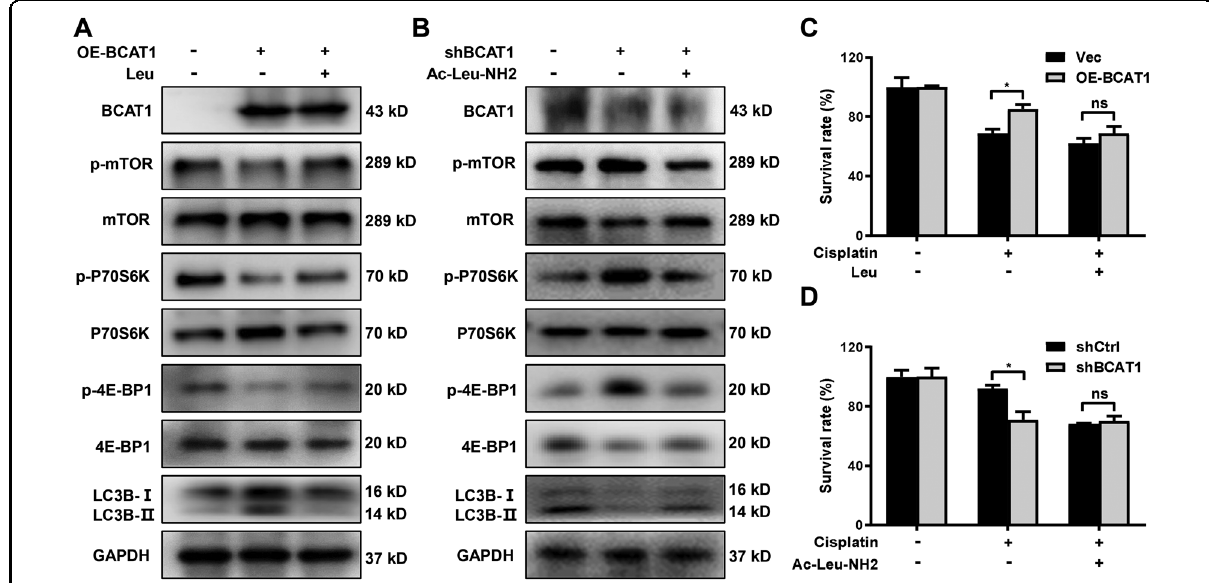
Fig. 5 BCAT1 enhances autophagy and decreases cisplatin sensitivity via leucine (Leu) reduction. A Western blot analysis of the protein levels of BCAT1, mTOR, p70S6K, 4E-BP1 and their phosphorylated counterparts and LC3-I/II in Hela cells with BCAT1 overexpression or in combination with Leu (2 mM) treatment for 24 h. B Western blot analysis of the protein levels of BCAT1, mTOR, p70S6K, 4E-BP1 and their phosphorylated counterparts and LC3-I/II in HepG2 cells with BCAT1 knockdown or in combination with an Ac-Leu-NH2 (5 mM) treatment for 24 h. C Hela cells overexpressing BCAT1 were treated with cisplatin (20 μ M) alone or in combination with Leu (2 mM) for 24 h. Cell viability was assessed by CCK-8 assays. D BCAT1 knockdown HepG2 cells were treated with cisplatin (10 μ M) alone or in combination with Ac-Leu-NH2 (5 mM) for 24 h. Cell viability was assessed by CCK-8 assays. Vec, empty vector; Ctrl, control. Three independent experiments were performed. ns, not signi fi cant. * P <